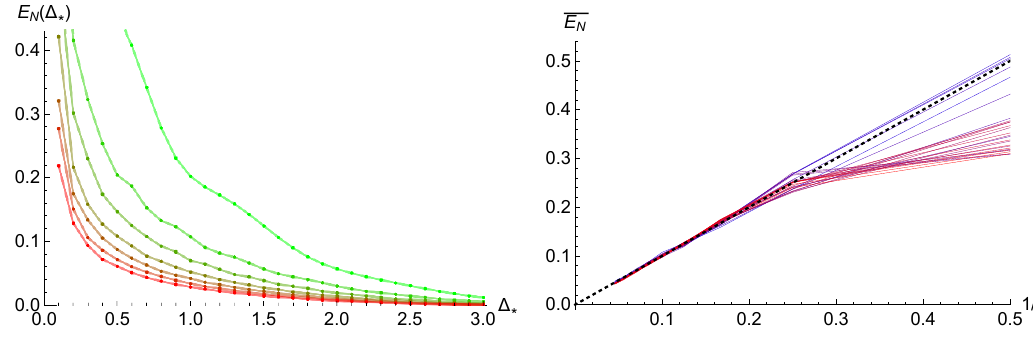
Figure 13 . Plots of approximation errors for n + m even. Left : E N as a function of (cid:1) (cid:3) for N from 4 (green) to 28 (red) in steps of 4. Right : normalized E N as a function of N (cid:0) 1 for (cid:1) (cid:3) from 0 : 4 (blue) to 1 : 5 (red). The dashed black line is shown for comparison and has slope 1.